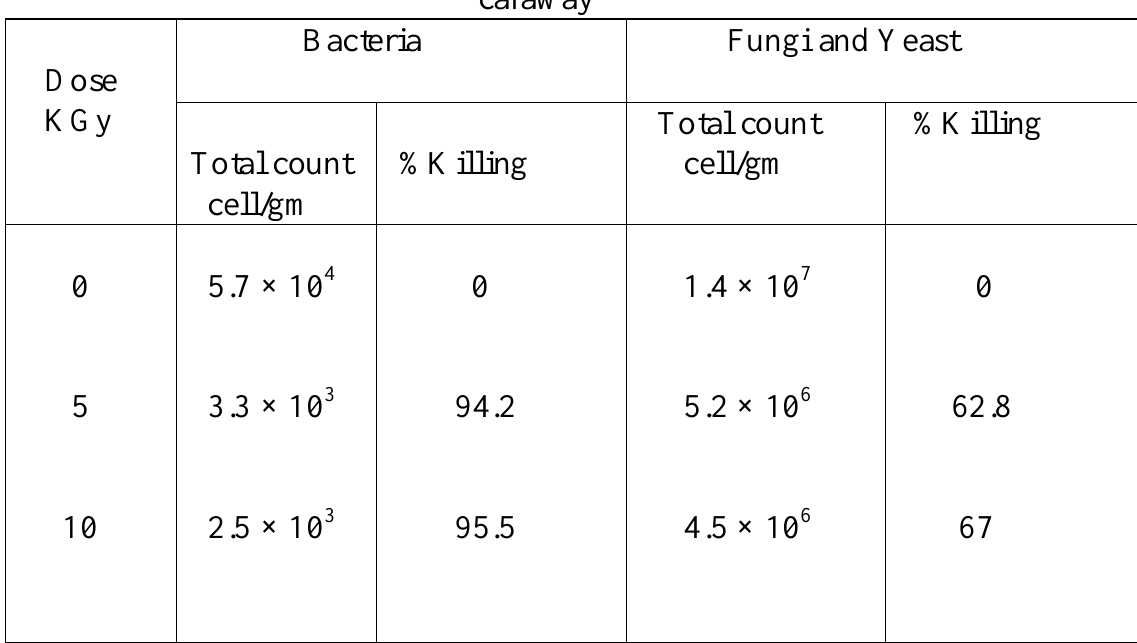
Table (2): Effects of 5KGy and 10KGy gamma radiation on total microbial counts